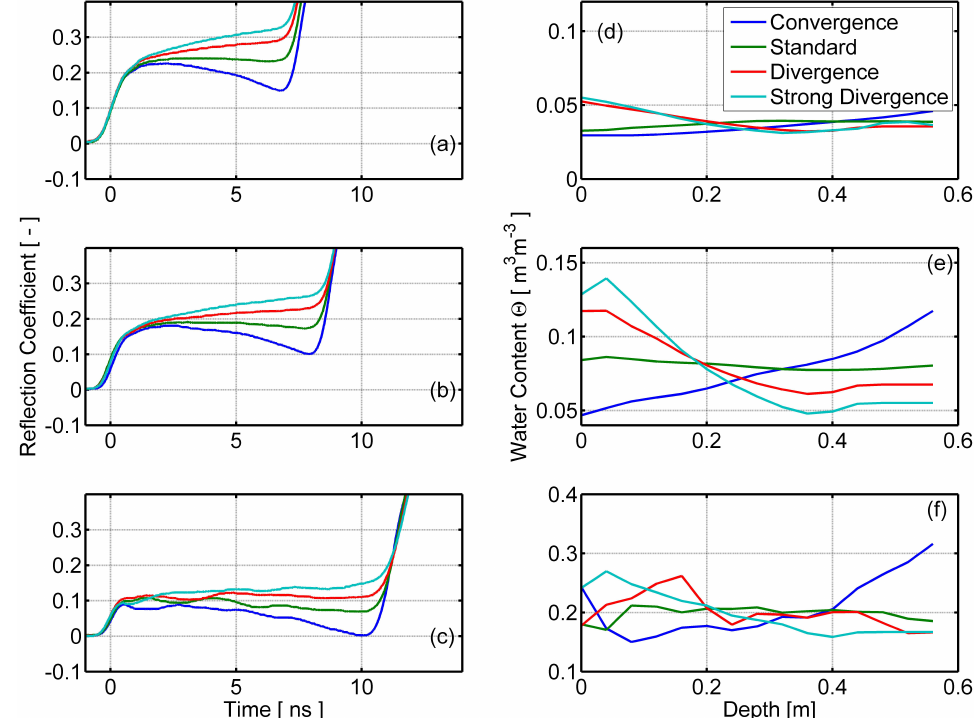
Fig. 7. Reflectograms and inverted soil moisture profiles obtained with different probe deformations at a soil moisture of approximately 0.04m 3 m − 3 (a) and (d) ; 0.08m 3 m − 3 (b) and (e) ; and 0.20m 3 m − 3 (c) and (f) . Standard denotes according to Fig. 3 ideal geometry, Convergence means convergent rods with increasing depth, Divergence and Strong Divergence values signifies a divergent probe as described in Fig.